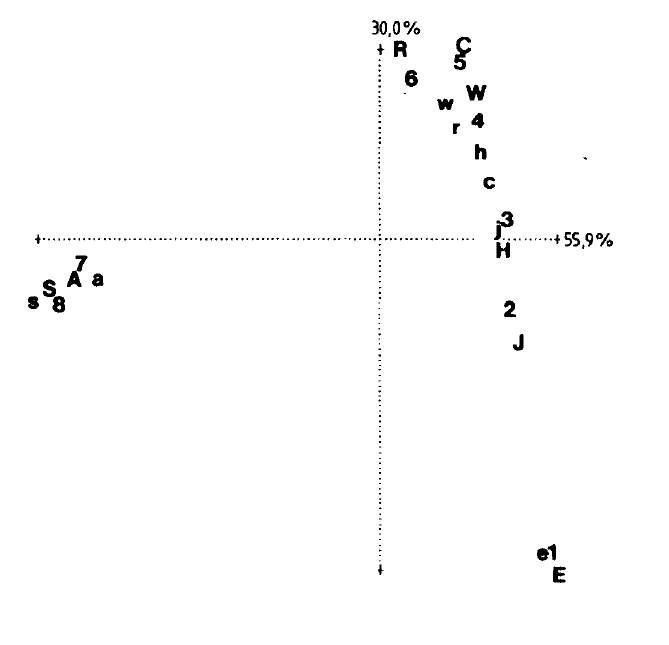
Figure 2 Perceptual Map showing the ranking of eight spheres of activity for apportioning corporate social funding. Note that the lower case symbols refer to the professional ecologists, and the upper case symbols to the business leaders. The numbers refer to the rank positions. See Table 1 for the legend explaining the